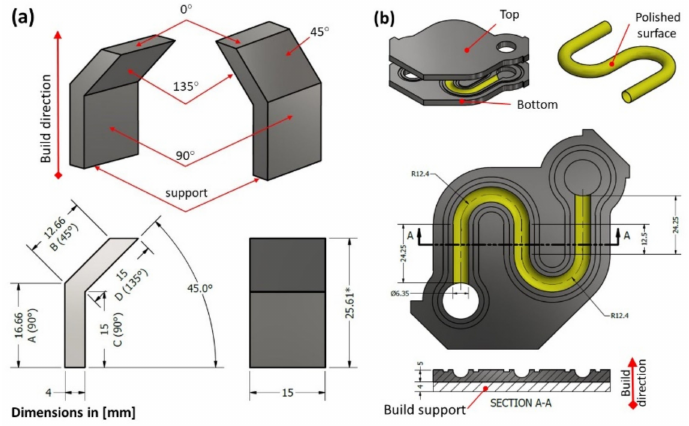
Figure 2. Parts used for the model development: ( a ) V-Shape (calibration artifact); ( b ) S-shape (validation specimen); arrows indicate the build directions for the ( a ) V-shape artifact, and ( b ) top and bottom halves of the S-shape specimen.